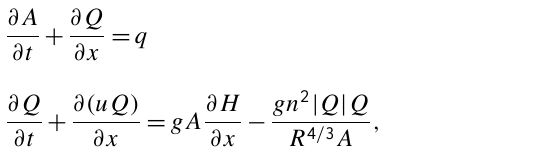
Fig. 2. Concept of buildings sharing